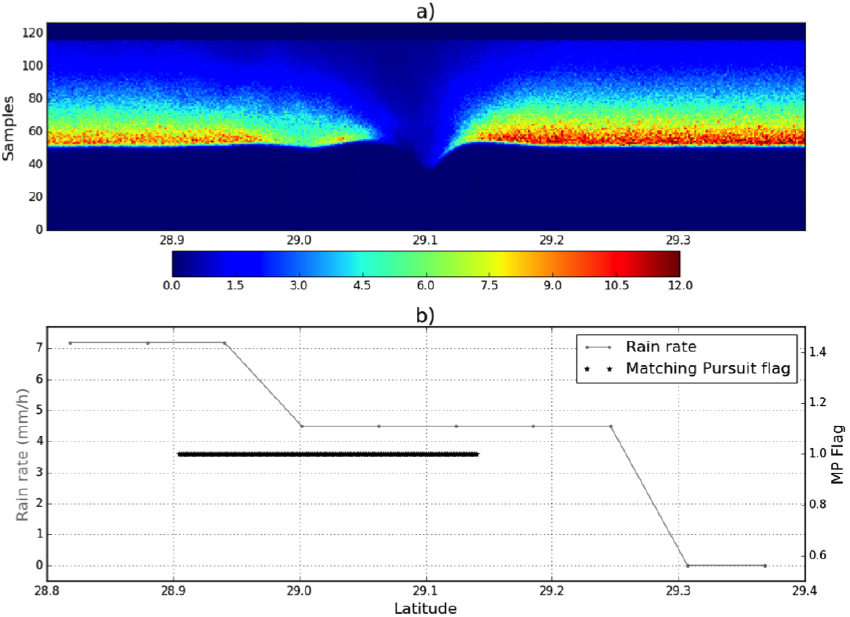
Figure 19. ( a ) AltiKa waveforms corrected from Automatic Gain Control during a rain event, pass 121 cycle 5; ( b ) collocated rainfall rate from SSMI and WindSat measurement in grey and Matching Pursuit flag in black